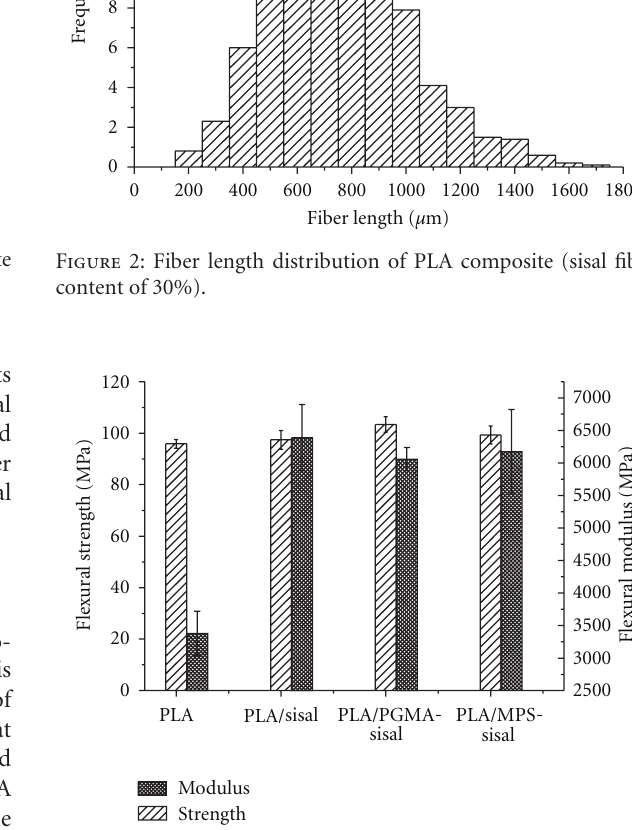
Figure 3: Flexural properties of 30 wt.% surface-treated Sisal fibers compared to untreated Sisal fibers reinforced